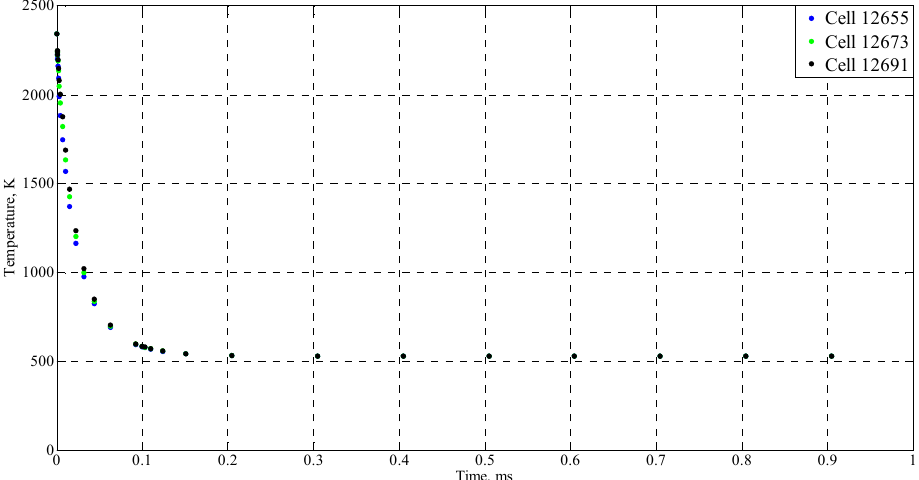
Figure 17. Temperature evolution in the cells 12655, 12673 and 12691 with preheating substrate.